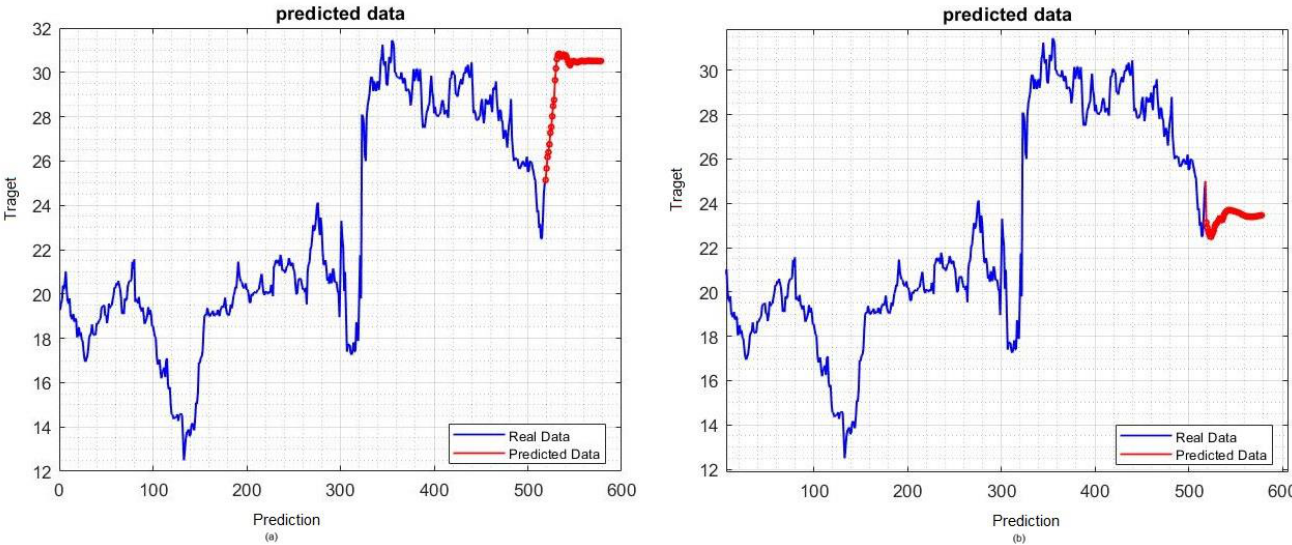
Figure 14. Forecasting the future values of Tesla using ( a ) CNN-LSTM and ( b ) LSTM.